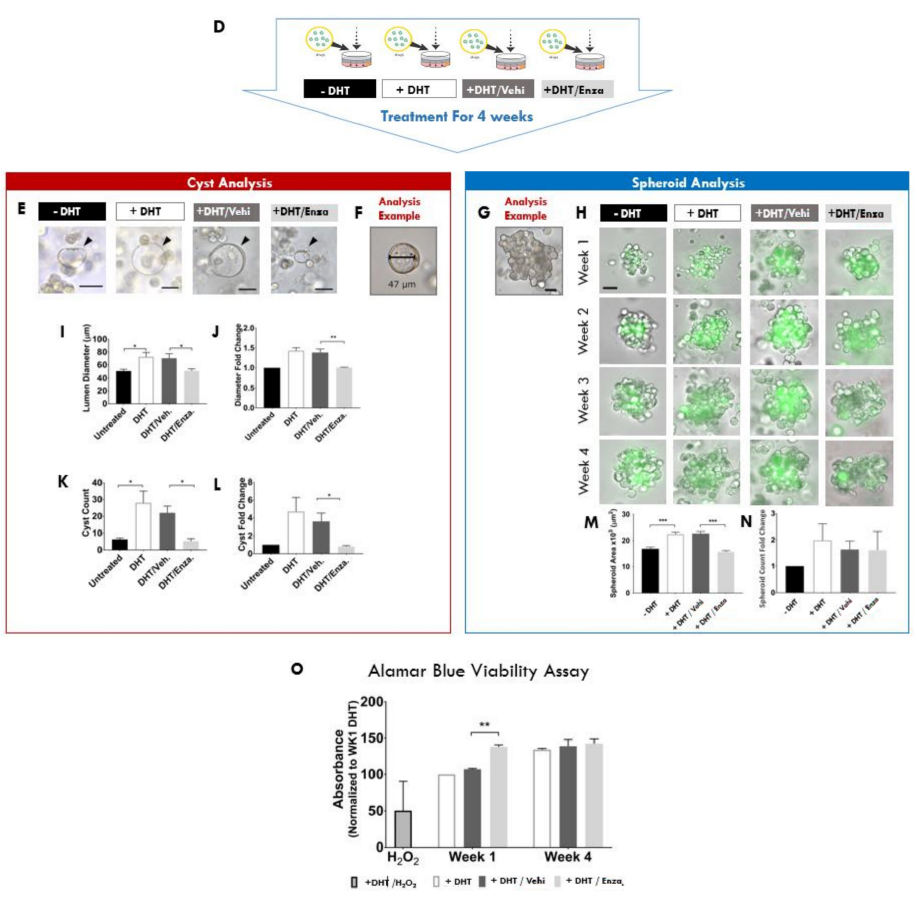
Figure 1. PDX-derived organoids (PDOs) recapitulate heterogeneity and androgen pathway di- rected therapy (APDT) resistance of the patient’s tumor. ( A ) Workflow to establish and optimize 3D organoids from patient-derived xenograft (PDX) model of prostate cancer bone metastasis. ( B ) Representative images of hematoxylin and eosin (HE) stained samples of prostatectomy tis- sue from the donor patient, PCSD1 intra-femoral xenografts and PCSD1 organoids. Red arrows point to structures seen in both the organoids and xenografts growing in the femur. HE images are shown at 10 × magnification. ( C ) A heterogeneous mix of PCSD1 tumor cells grown in 3D organoid cultures consisting of single cells, hollow epithelial cysts and cell-filled spheroids. Bright-field microscope images of single cells and the spheroid are at 10 × magnification and the cyst is at 20 × magnification. Scale bars represent 50 µ m. ( D ) Experimental design of 3D cultures of PCSD1-GFP/luciferase express- ing organoids under four treatment conditions: -DHT, +DHT (1 nM), +DHT/Vehicle (1 nM/0.1% DMSO) and +DHT/enzalutamide (1 nM/10 µ M). PCSD1 organoids in each treatment group were imaged weekly with a Keyence digital microscope for four weeks. ( E ) A representative image of cysts in each treatment condition after four weeks of treatment. ( F ) A measurement example of cyst lumen diameter using the Hybrid Cell Counter software. Scale bar for spheroid image is 50 µ m. After measurement of cyst lumen diameter, the number of epithelial cysts greater than 50 µ m in size was quantified in each culture. ( G ) An analysis example of spheroid area using the Hybrid Cell Counter software. Scale bar for spheroid image is 50 µ m. ( H ) A representative image of spheroid in each treatment condition at week 1, 2, 3 and 4 of treatment. ( I ) Average lumen diameter of cysts. ( J ) Fold changes in lumen diameter. ( K ) Number of cyst count. ( L ) Fold changes in cyst count. ( M ) Average spheroid area. ( N ) Fold changes in the number of spheroids under four treatment conditions: − DHT, +DHT (1 nM), +DHT/Vehicle (1 nM/0.1% DMSO), and +DHT/enzalutamide (1 nM/10 µ M). For fold change analysis in ( J , L , N ), quantified values were normalized to the DHT- condition. ( O ) The Alamar Blue viability assay performed on the cultures at weeks 1 and 4. Cell viability was determined using the 50 µ L of the AlamarBlue reagent per well in 24-well plate (Invitrogen, by Life Technologies